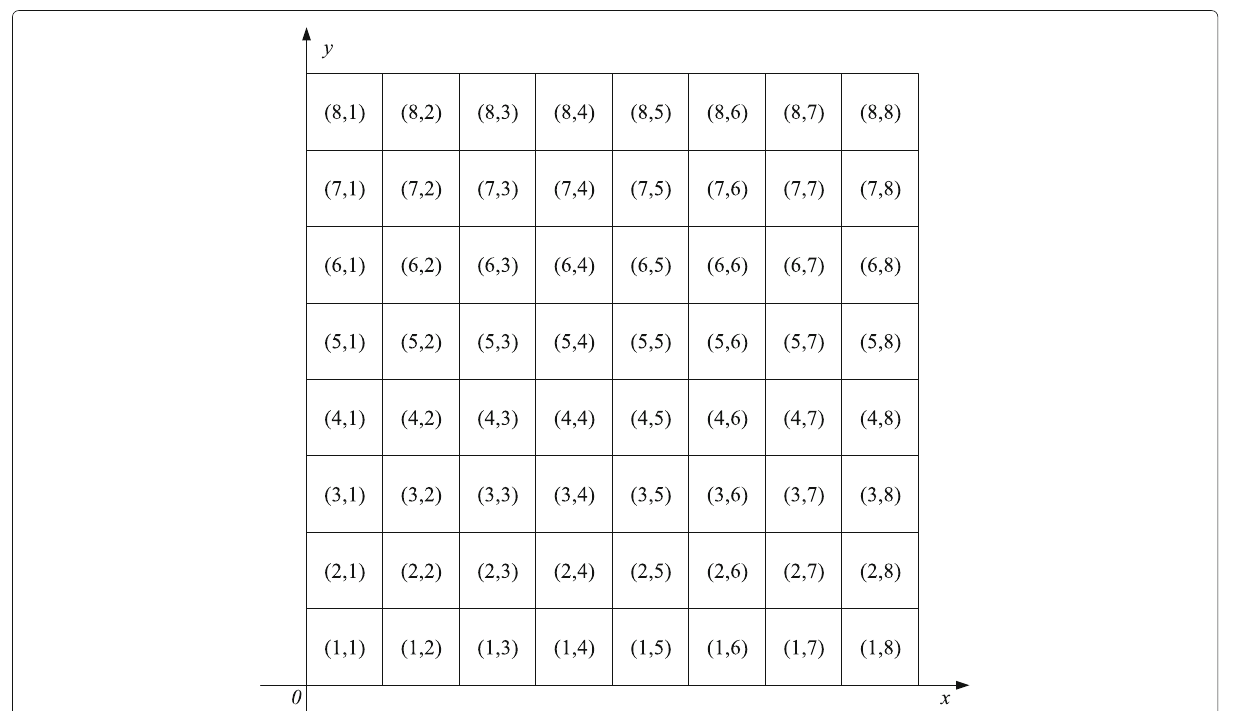
After the operation of adding, sensor nodes sort their election lists. The election lists are sorted in ascending order by the abscissa, and if some sensor nodes have the same abscissas, the lists are sorted in ascending order by the ordinate. After the sorting operation, the sensor nodes in the same grid cell have the same election list. If a sensor node finds itself at the top of the election list, the sen- sor node broadcasts information of CellHead within the √ 2 a . The broadcasted CellHead consists of the radius of indexes of sensor node in the election list. The other sen- sor nodes in the same grid cell receive the CellHead and